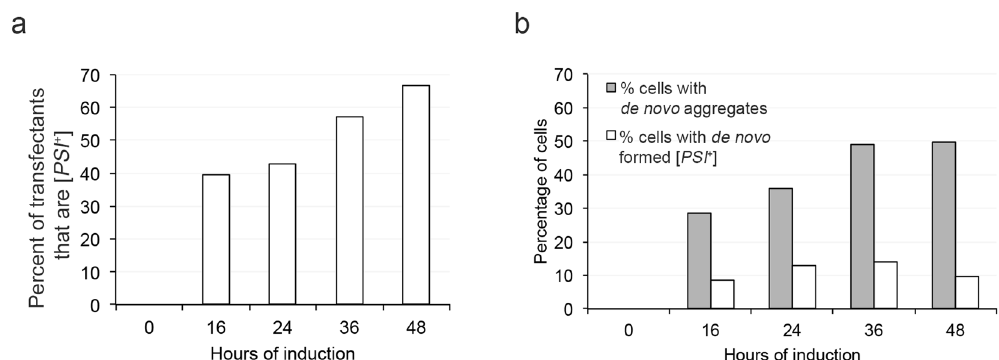
Figure 5. De novo induced prion particles are infectious. ( a ) Donor lysates from cultures induced for the indicated times (x-axis) were transfected into [ psi − ][ PIN + ] cultures. Transfection conversion frequencies are shown. ( b ) The same donor cultures, used in transfection, were also assessed for the ability to form Sup35PrD- GFP aggregates (rings, lines, and dots; grey bars) and de novo induction frequency (white bars). This data represents single trial out of three independent